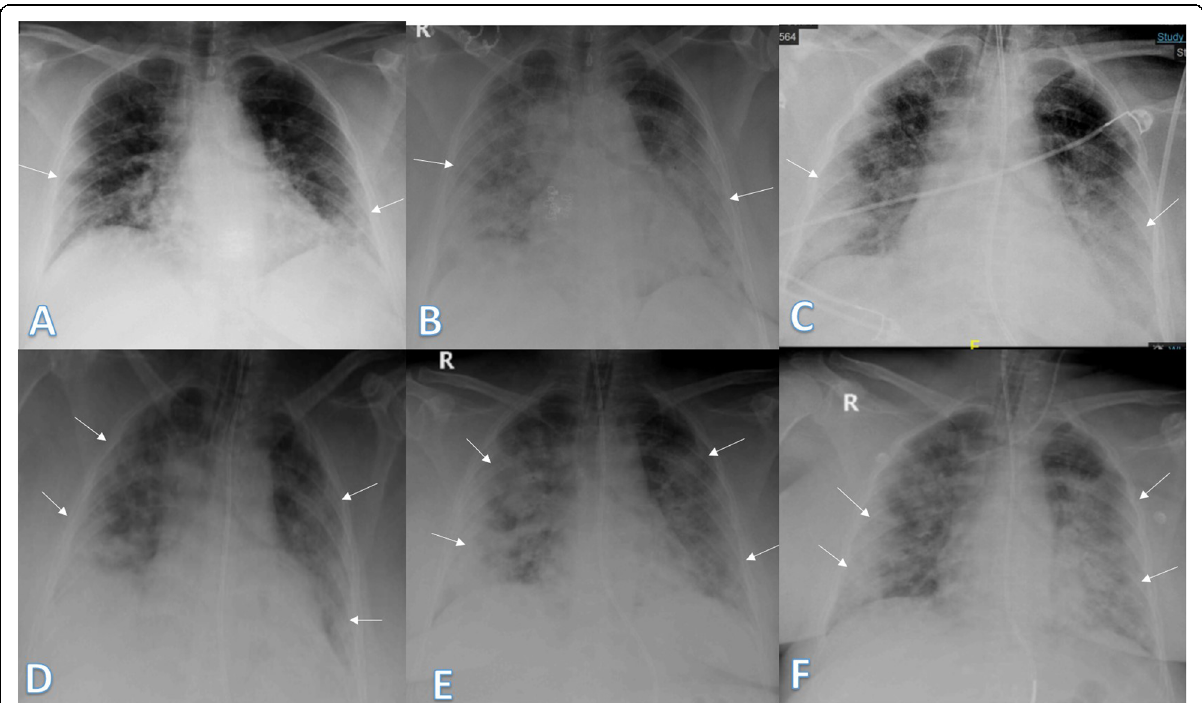
Fig. 20 59-year female with positive COVID-19 virus. Initial X-ray ( a ) showed small peripheral right and left lower zonal air space consolidation opacities (arrows) with TSS as 2. On the 3rd day ( b ), air space consolidation opacities significantly increased extending to the upper and middle zones of both lungs (arrows) with TSS as 6 (3 on each side). The patient deteriorated and was intubated. On the 5th day ( c ), 7th day ( d ), 9th day ( e ), and 11th day ( f ), there was confluent bilateral air space consolidation opacities (arrows) with the severity score 4 on each side, so TSS was 8. The patient died on the 13th